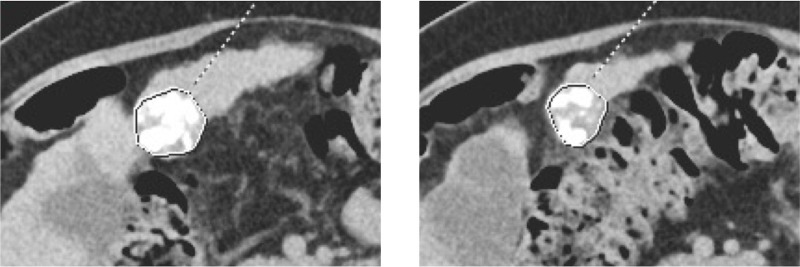
Example measurement.Measurement of the density and area of iodine depositions using a polygon ROI in Syngo.via. The polygon ROI was plotted around the iodine depositions of HCC, previously treated with cTACE in a superselective manner.